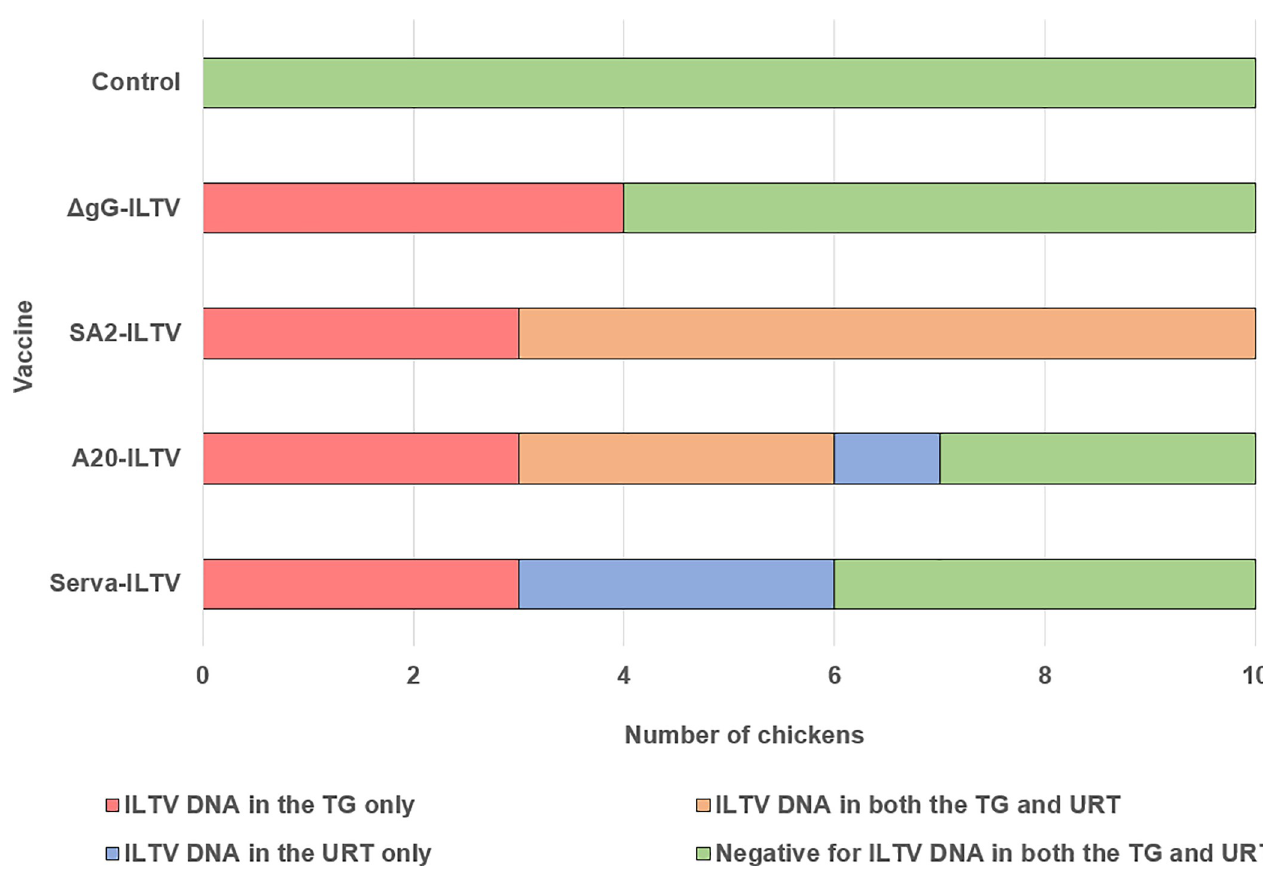
Fig 1. Summary of ILTV DNA detection results at day 21 post vaccination. The presence of ILTV DNA in the TG only suggests latent infection. The presence of ILTV DNA in the TG and URT suggests concurrent latent and lytic infection. The presence of ILTV DNA in the URT only suggests lytic infection.